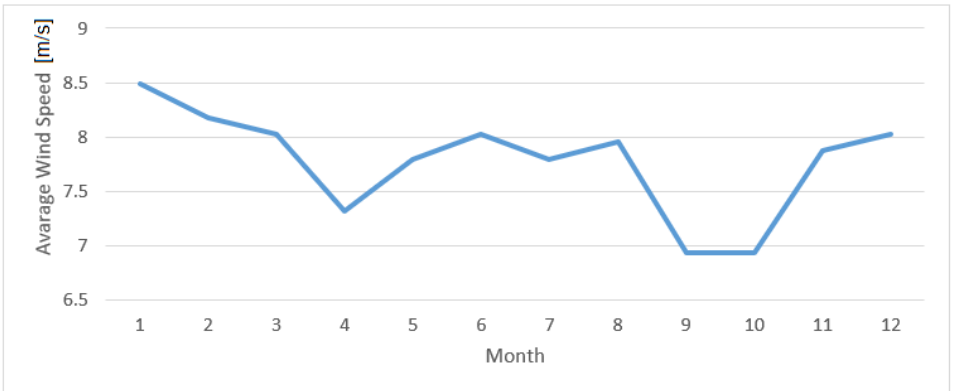
Figure 2. Wind Speed (m/s) Variability at 100 m